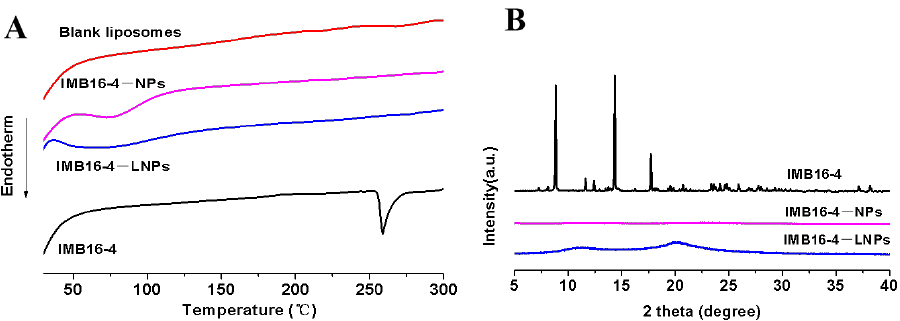
Figure 3. DSC ( A ) and XRD ( B ) analysis of blank liposomes, IMB16-4 −NPs, IMB16 -4, and IMB16- 4 −LNPs. For DSC analysis, samples were heated from 30 to 300 °C at a heating rate of 10 °C/min under a nitrogen purge of 50 mL/min. The patterns of XRD were performed from 5° to 40° (diffraction angle 2θ) at a step size of 0.02°.